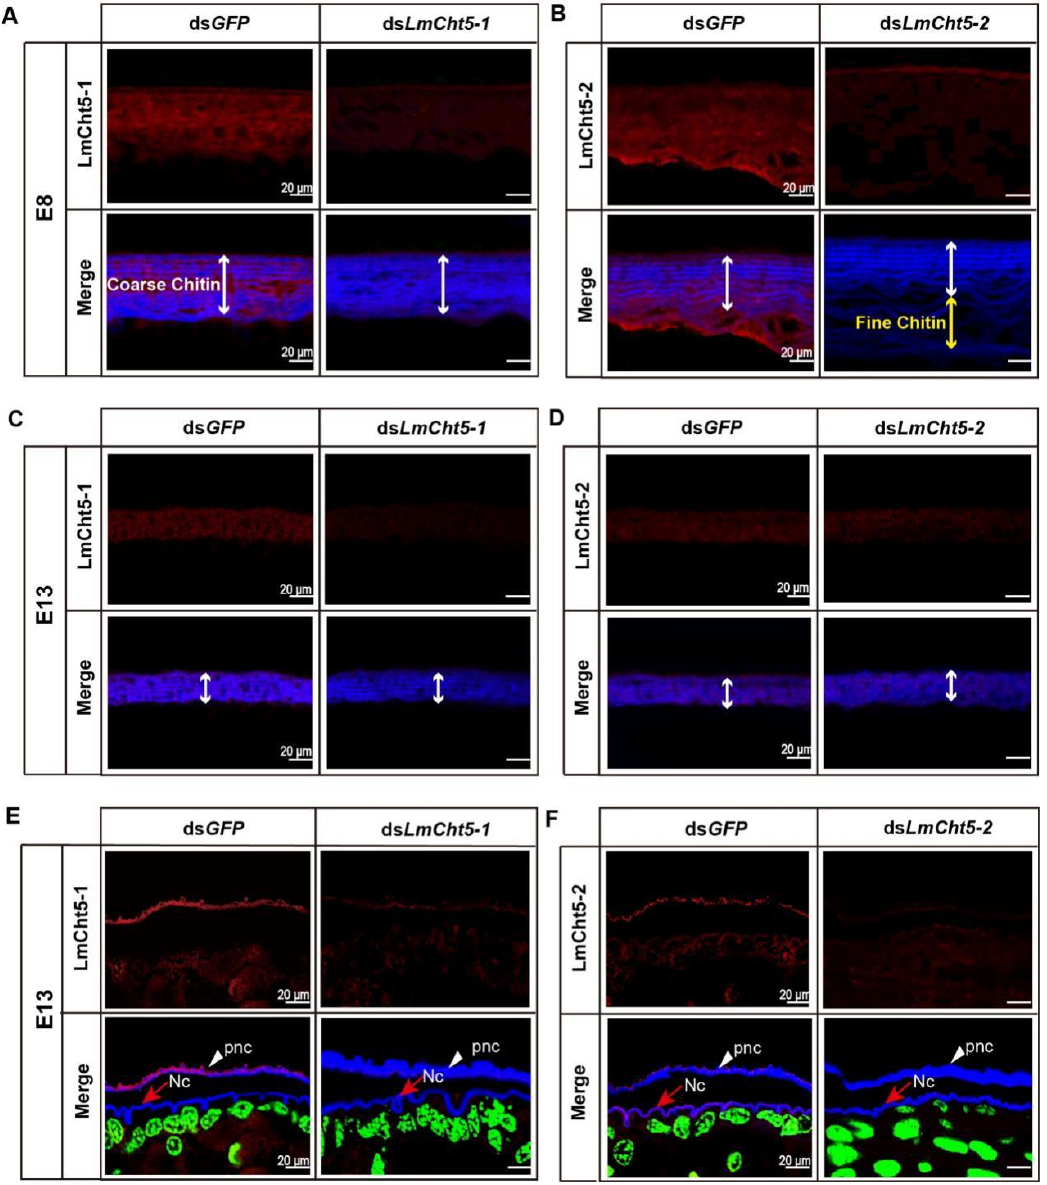
Figure 4. ds LmCht5-1 and ds LmCht5-2 inhibit the degradation of chitin both in the serosal cuticle and the pro-nymphal cuticle. Paraffin sections (5 µ m) of eggs after RNAi was collected for analysis of chitin and protein differences. ( A ) The degradation of fine structure chitin in the lower part of the serosal cuticle at E8 was not affected by ds LmCht5-1 microinjection at E5. ( B ) The degradation of fine structure chitin in the lower part of the serosal cuticle at E8 was not obviously inhibited by ds LmCht5-2 microinjection at E5. ( C , D ) The degradation of coarser structure chitin in the upper part of the serosal cuticle at E13 was not obviously affected by ds LmCht5-1 ( C ) and ds LmCht5-2 ( D ) microinjection at E7. ( E ) The degradation of chitin in the pro-nymphal cuticle at E13 was significantly inhibited by ds LmCht5-1 microinjection at E7. ( F ) The degradation of chitin in the pro-nymphal cuticle at E13 was inhibited by ds LmCht5-2 microinjection to a certain extent at E7. The scale bar is 20 µ m. The white line shows the coarse chitin in the upper part, while the yellow line shows the fine layer in the lower part. The blue label indicates chitin, and the green indicates cells. Both LmCht5-1 and LmCht5-2 are indicated by the red signal of the antibody. pnc: pro-nymphal; Nc: New